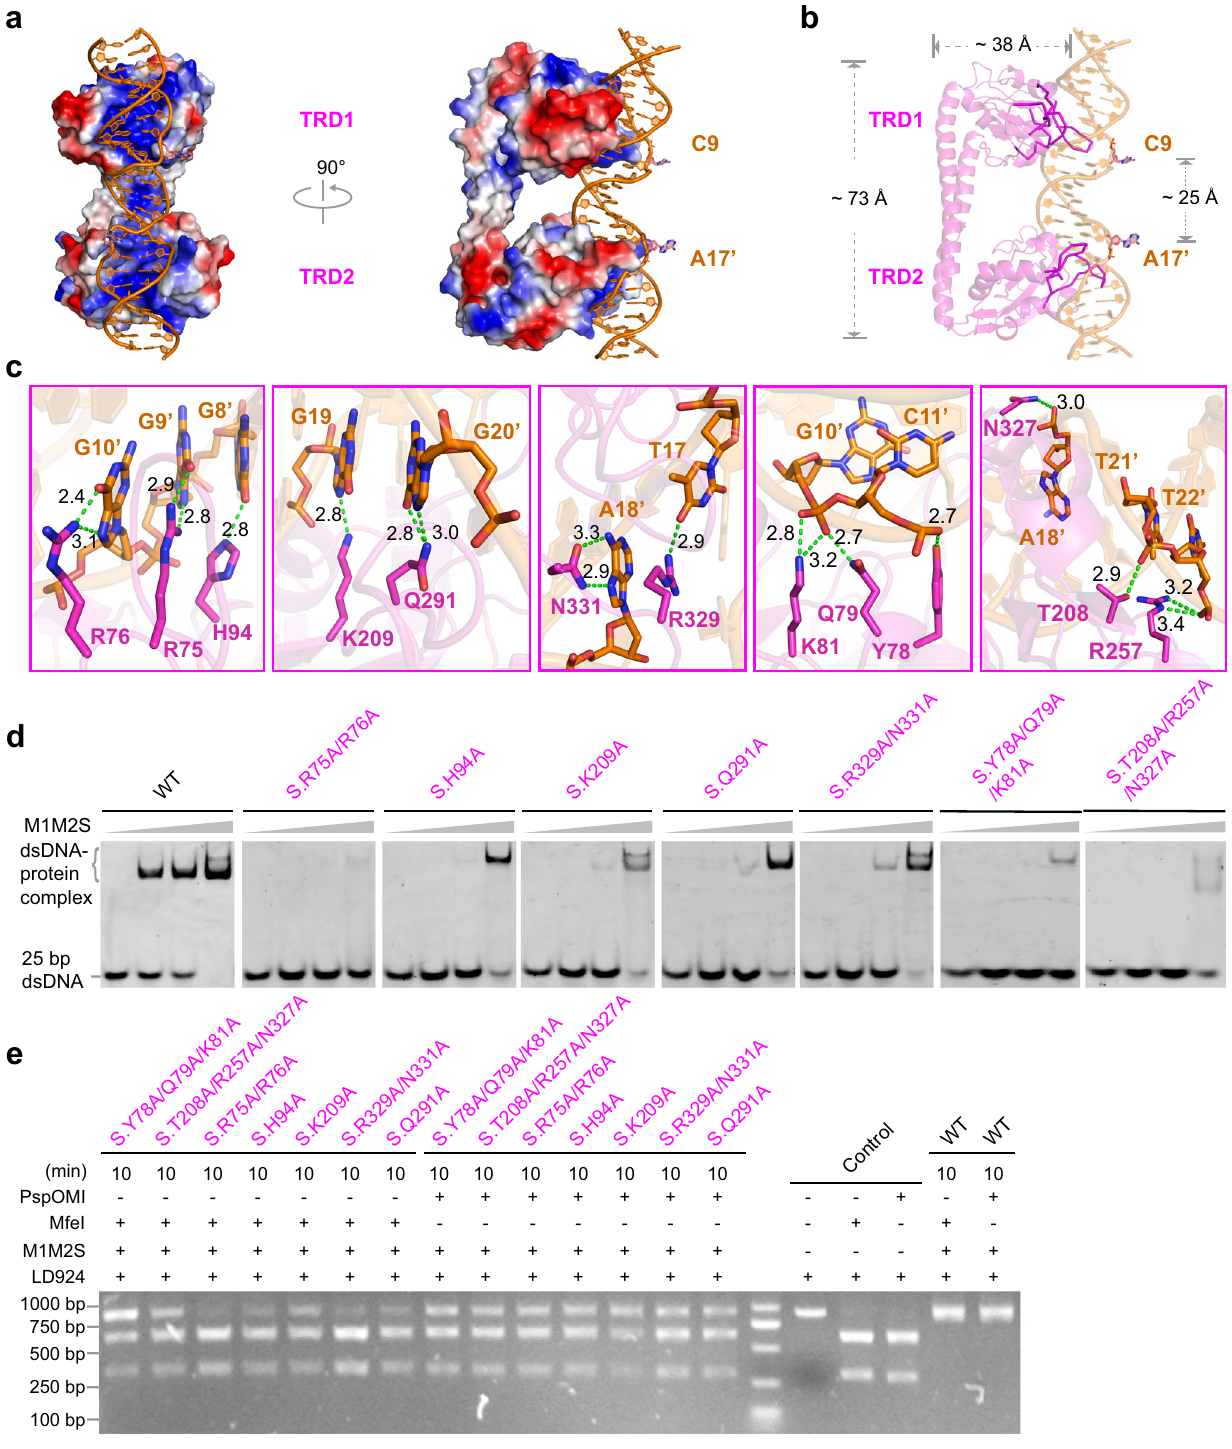
Fig. 3 | Speci fi c recognition of target DNA by S subunit of PacII MTase. a Electrostatic surface of S subunit bound to target DNA, where the red indicated for negative and blue for positive charges. b Cartoon representation of S subunit bound to target DNA,with outward-loops of TRD1/TRD2 insertinto the grooves of bipartite DNA. c Detailed speci fi c and non-speci fi c interactions between the loop